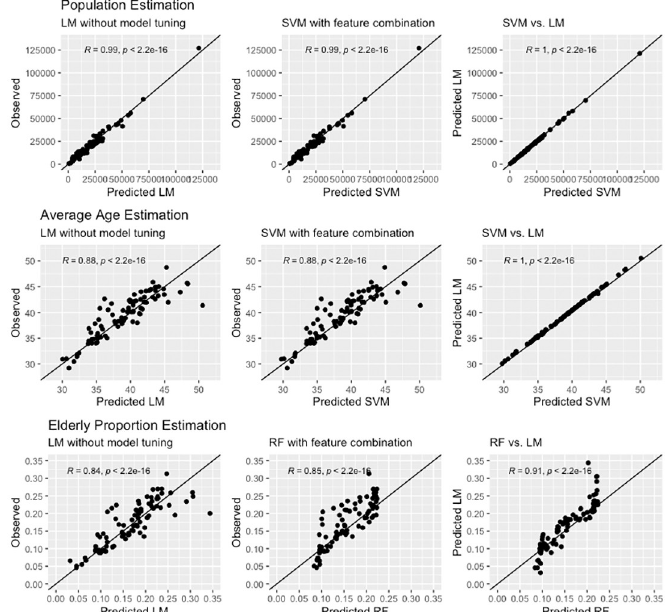
Fig 5. Observed vs predicted and predicted vs predicted (models) scatterplots for population count, average age, and elderly proportion. LM and SVM tend to produce very similar predictions (population counts and average age), while RF and LM reveal differences in particular for lower and higher values (elderly